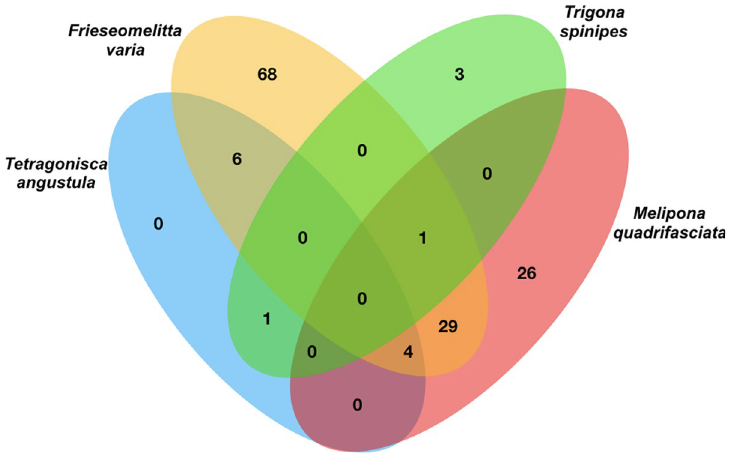
Fig 4. Venn-diagram showing the distribution of bacterial genus.